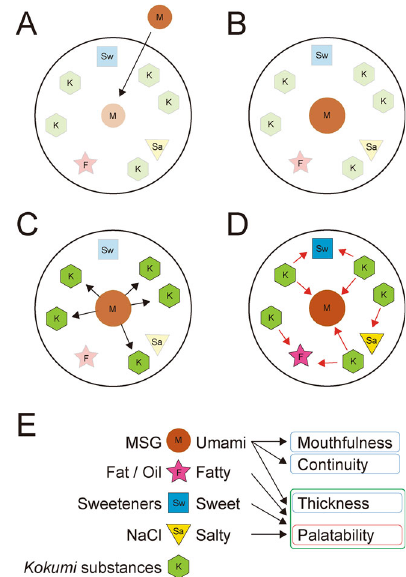
Fig. 2 A theoretical representation of the mechanism underlying how the addition of monosodium glutamate (MSG) induces kokumi and palatability in food containing kokumi and basic taste substances. When MSG is added to food ingredients ( A ), the amount of MSG is increased ( B ). Increased MSG facilitates the binding of kokumi substances to kokumi receptors ( C ). The bound kokumi substances facilitate the binding of sweet, salty, and fatty substances to their corresponding receptors and enhances those tastes ( D ). Enhanced umami induces mouthfulness and continuity of sensation. Thickness comes from enhanced perception of the four tastes, and palatability is also induced on the basis of these palatable tastes ( E